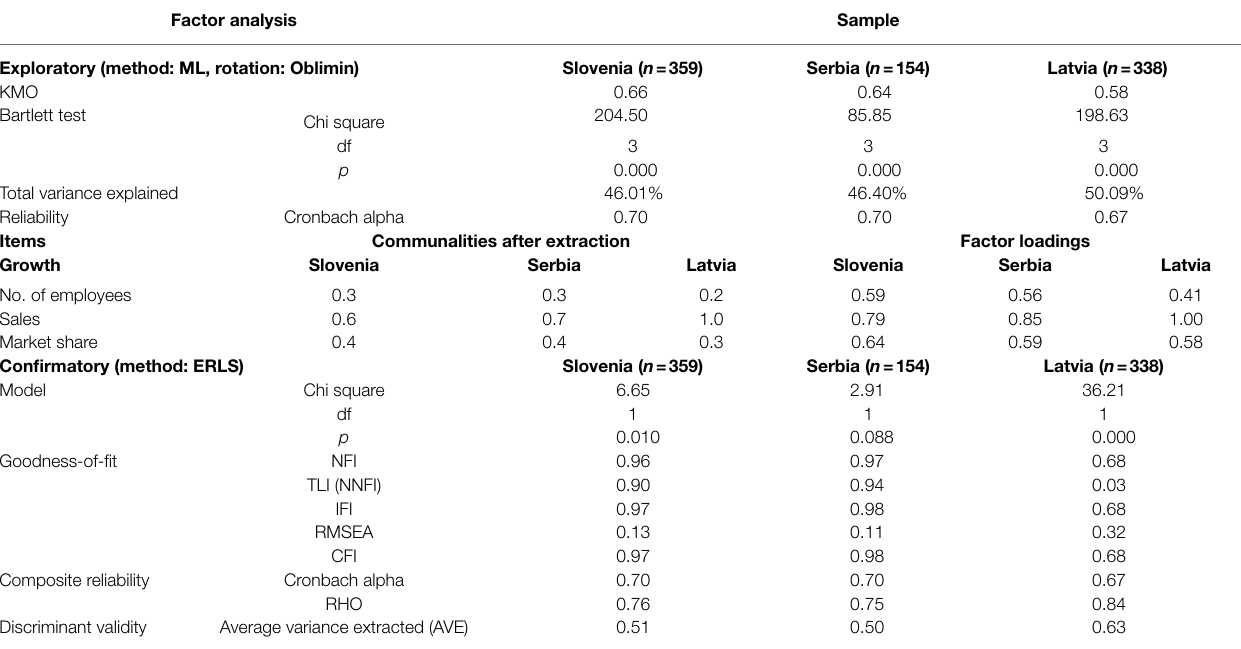
TABLE 5 | Firm growth construct—factor analysis results. Factor analysis